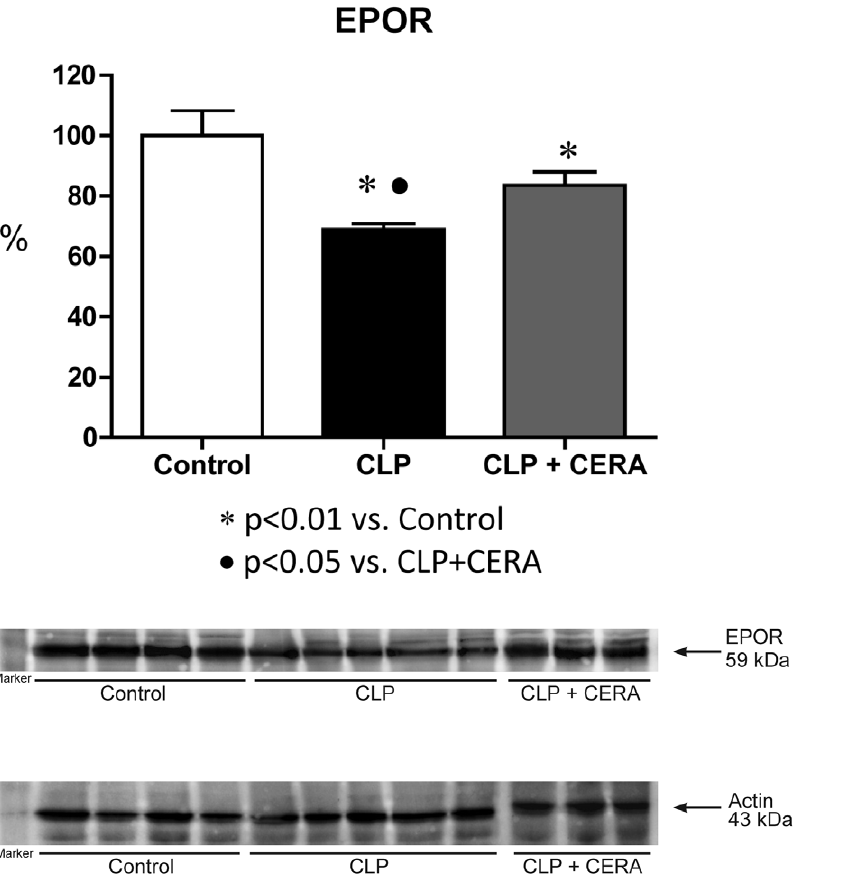
Figure 3. Erythropoietin receptor expression was partially protected in the rats pretreated with continuous erythropoietin receptor activator. Semiquantitative immunoblots prepared from kidney samples. Densitometric analysis of all samples from control rats, rats submitted to cecal ligation and puncture only, and rats treated with continuous erythropoietin receptor activator prior to undergoing cecal ligation and puncture. Differences among the means were analyzed by analysis of variance followed by the Student-Newman-Keuls test. p . 0.05 for control vs. CLP + CERA. CLP, cecal ligation and puncture; CERA, continuous erythropoietin receptor activator; EpoR, erythropoietin receptor.